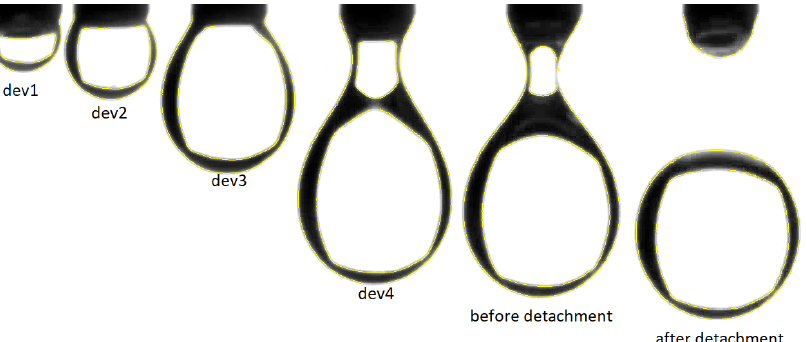
Figure 3. A droplet with its edges detected in yellow during its different states: the four droplets from the left show the development phase. Fifth droplet from the left: completely formed droplet in the frame just before the detachment. Last droplet: after